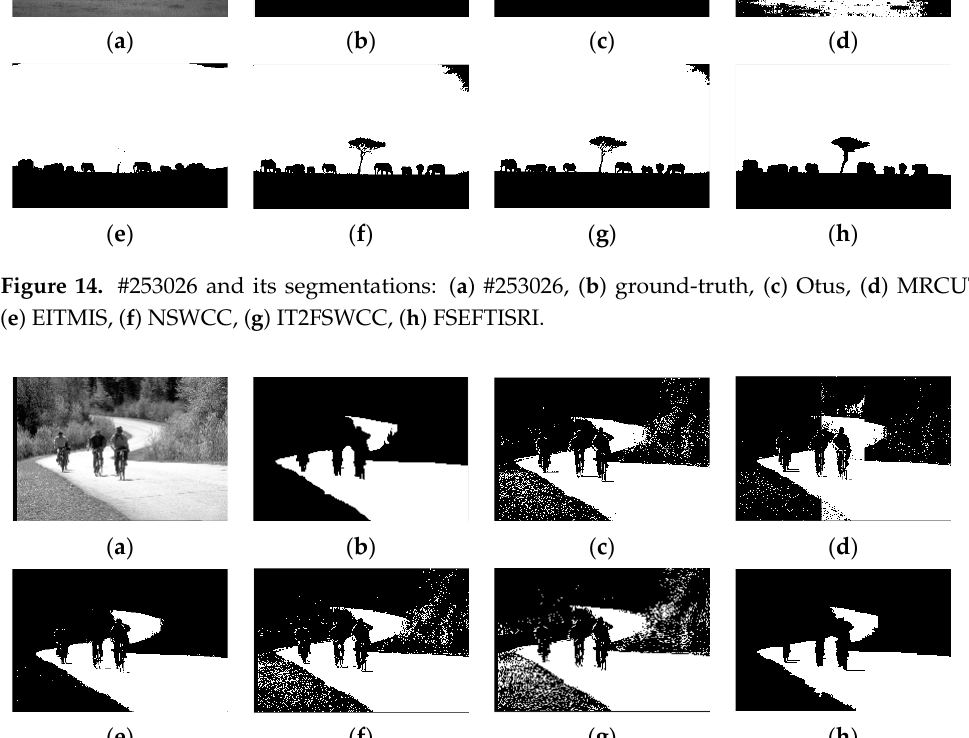
Figure 15. #344010 and its segmentations: ( a ) #344010, ( b ) ground-truth, ( c ) Otus, ( d ) MRCUT, ( e ) EITMIS, ( f ) NSWCC, ( g ) IT2FSWCC, ( h )